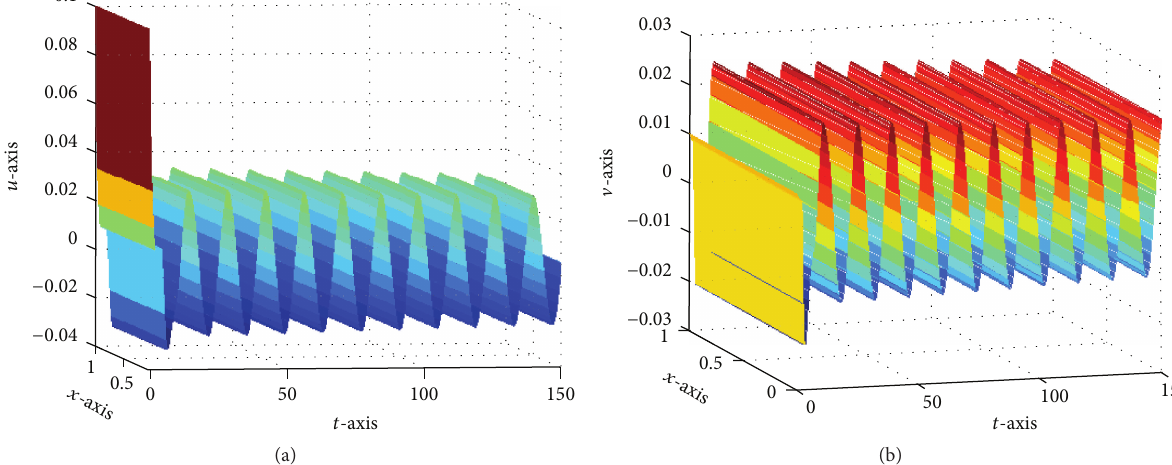
Figure 2: The temporal solution found by numerical integration of systems (64) and (66) with 𝜏 = 4.25 : (a) 𝑢(𝑡,𝑥) and (b) V (𝑡,𝑥) .